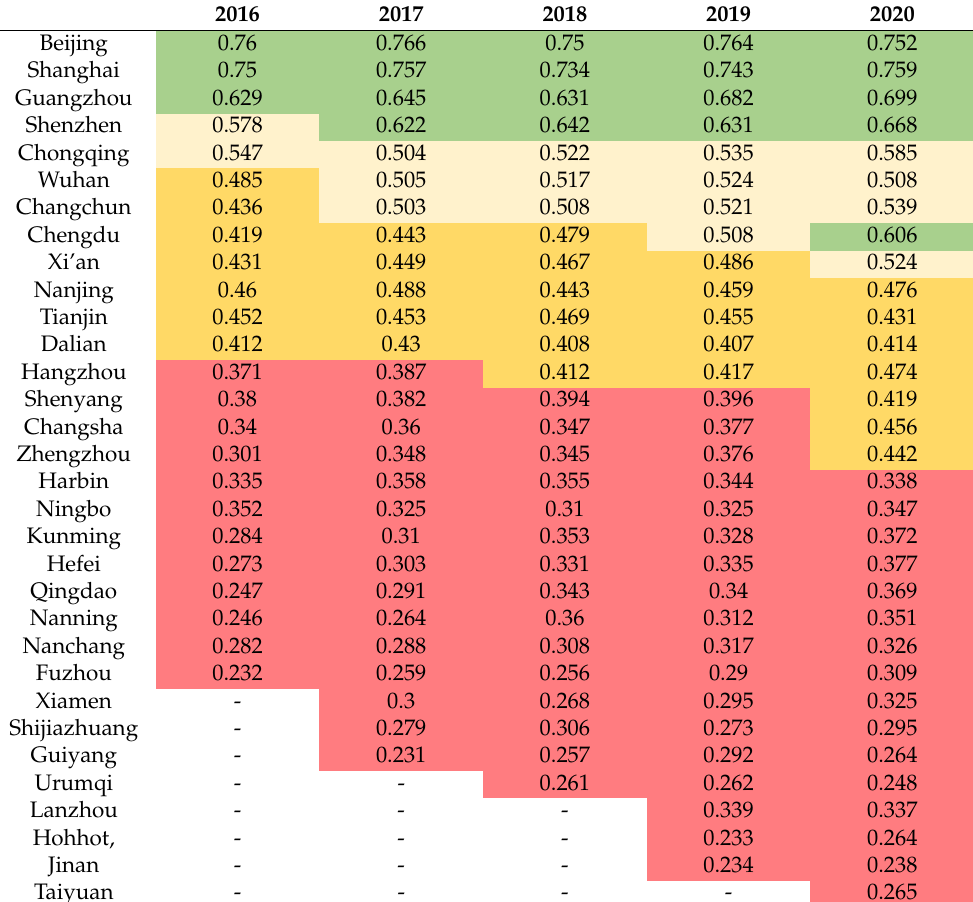
Table A4. Coupling coordination relationship among R-T in 36 cities in China. Note: “-” represents no final data result for the corresponding cities.